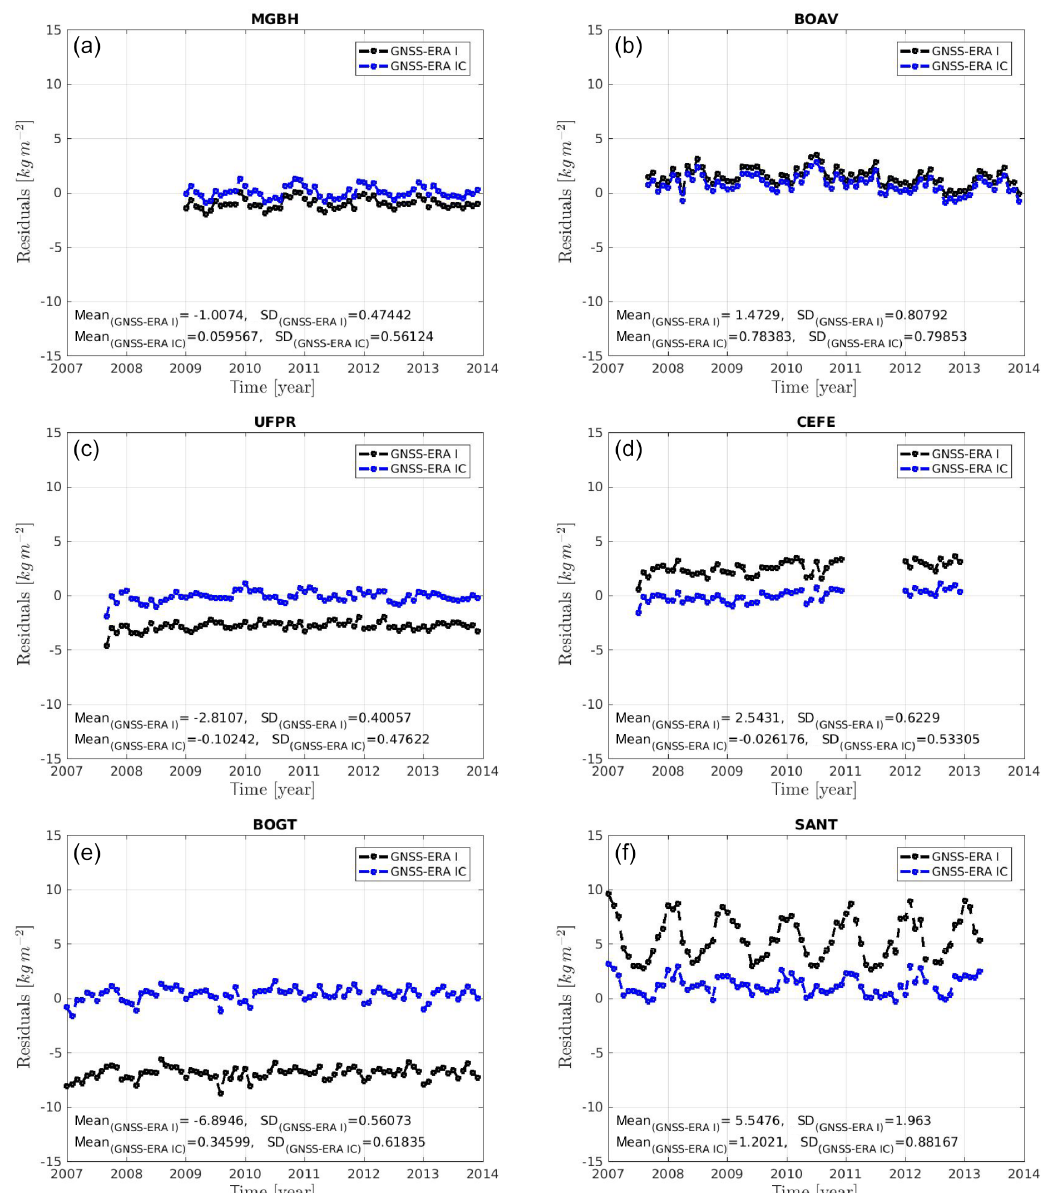
Figure 5. Residuals of the difference between IWV GNSS and IWV ERA-Interim (black line) along with residuals of the difference between IWV GNSS and ( IWV ERA-Interim + correction ) (blue line). Panels (a) , (c) and (e) show stations with positive (cid:49)z , which means that the GNSS station is higher than the location assigned by ERA-Interim; the opposite is shown in panels (b) , (d) and (f) . Mean values of the residuals along with the standard deviations are also provided. The sites are shown according to (cid:49)z decreasing from top to bottom in each column. (cid:12) (cid:12) rable with the correspondent (cid:12) (cid:49) IWV (cid:12) values estimated in our study (6.87 kg m − 2 in BOGT and 2.03 kg m − 2 in BRAZ,